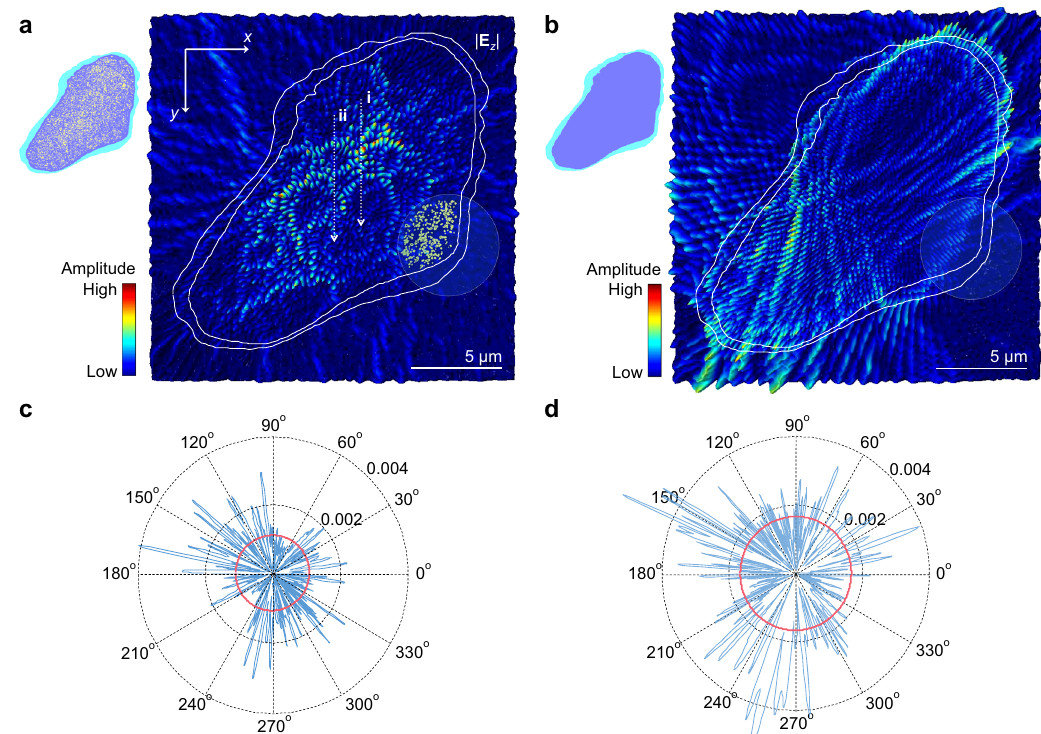
Fig. 2 Riddle of nano fi brils. a , b Electric fi eld amplitude | E z | of modes in a single silk fi lament with ( a ) and without ( b ) nano fi brillar structures. The spreads of the fi elds along (i) and (ii) are 2.7 and 9 μ m, respectively (Supplementary Fig. 4c, d). The overlays are the boundaries of sericin layers (white lines) and nano fi brils (yellow lines in inset of a ) for computations. The boundaries and domains of nano fi brillar, inter fi brillar and sericin areas are extracted from high- resolution TEM micrographs (Supplementary Fig. 1). c , d Far- fi eld radiation patterns computed from the fi eld of a , b using the near-to-far- fi eld transformation, respectively. The red circles are average outgoing fl